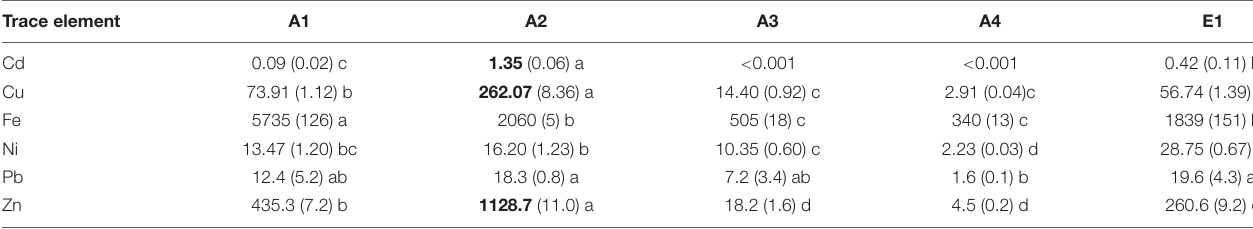
TABLE 3 | Total concentration of trace elements in chars from thermocatalytic reforming of digestate (A1), poultry litter (A2), and wood pellet (A3) and from pyrogasification of wood pellet (A4) and brushwood (E1). Trace